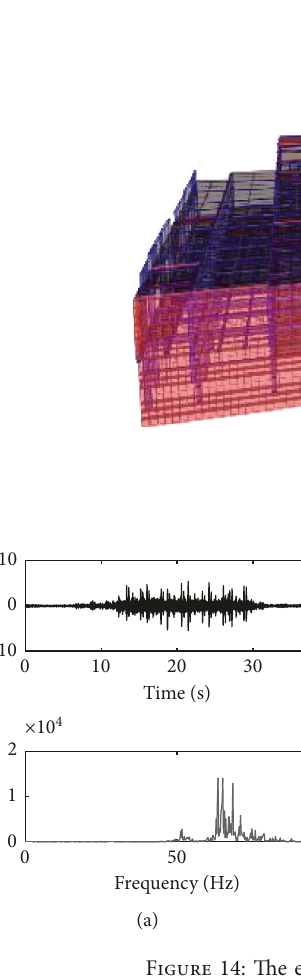
Figure 14: The excitations to be inputted. (a) X direction. (b) Y direction. (c) Z direction.